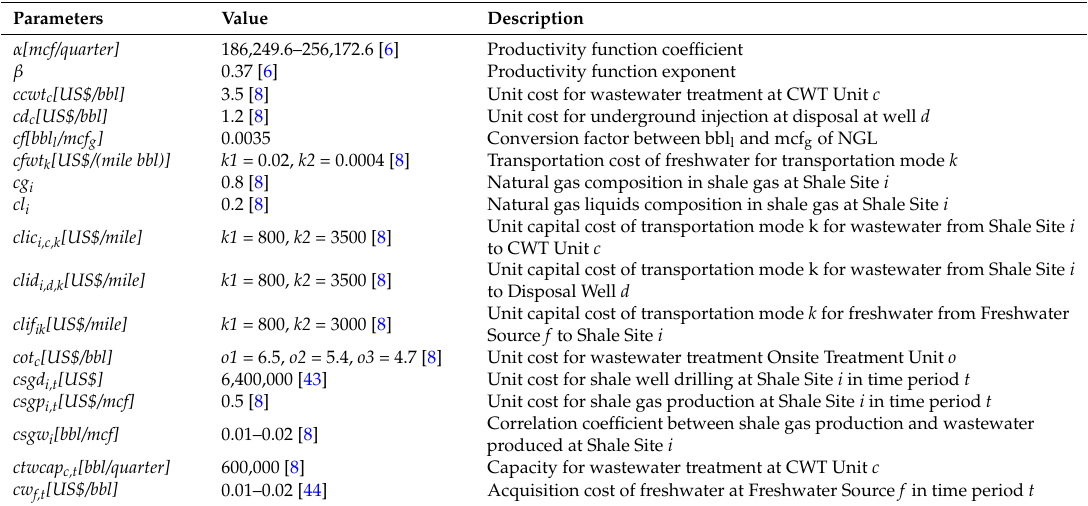
Table A1. Input data for case study utilized for the resolution of optimization